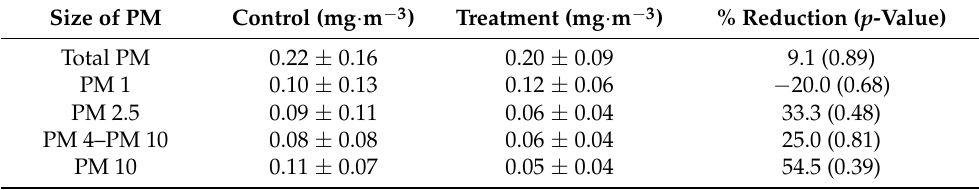
Table 6. Mitigation of PM with UV-A photocatalysis treatment. Control temperature = 28.5 ± 2.3 ◦